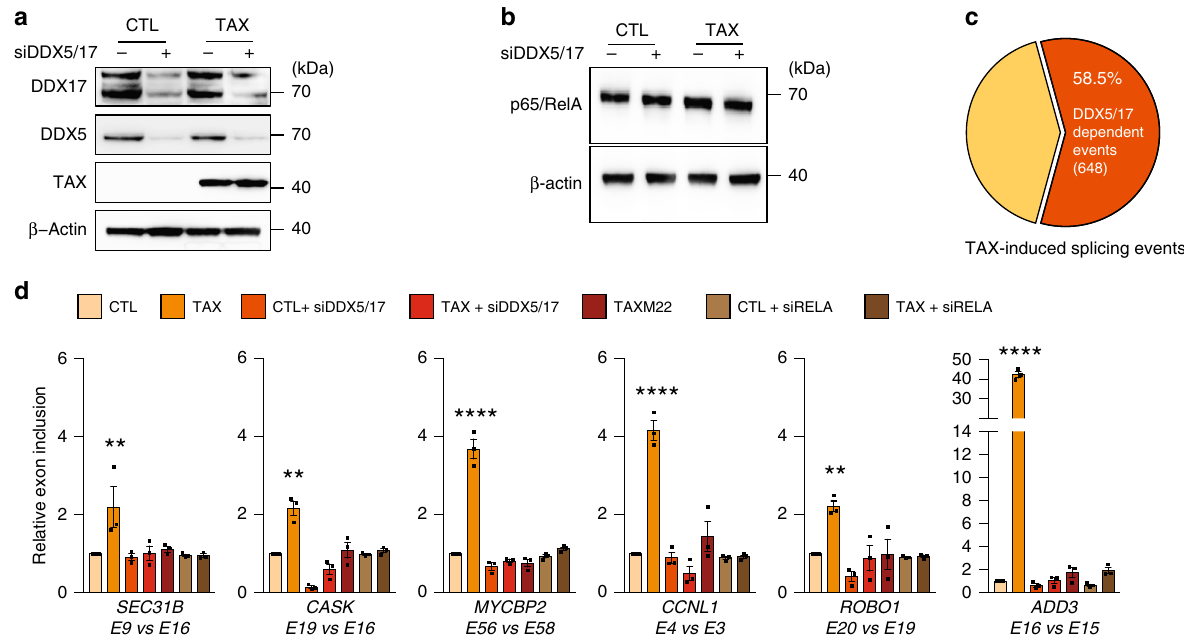
Fig. 3 DDX5/17 regulates Tax splicing targets in an NF-kB-dependent manner. a Western blot analysis of DDX5 and DDX17 expression in HEK cells expressing or not Tax and depleted or not of DDX5 and DDX17 by siRNA. b Western blot analysis of RELA and β -actin upon Tax expression and siRNA- DDX5/17 delivery. c Splicing events modi fi ed upon the depletion of DDX5/17 in Tax-positive HEK cells. The signi fi cant threshold was set to ≥ 2 in comparisons between TaxvsCTL and TaxsiDDX5/17vsCTL. For b and c , a representative image from three independent experiments is shown. d Validation of alternative splicing predictions of a set of Tax- and DDX5/17-regulated exons. TaxM22 and siRNA-mediated RELA depletion were used in order to assess the dependency of splicing events on NF- κ B activation. Histograms represent the results of exon-speci fi c quantitative RT-PCR measurements computed as a relative exon inclusion (alternatively spliced exon vs constitutive exon re fl ecting the total gene expression level). All genes but MYCBP2 were unmodi fi ed at the whole transcript level upon Tax expression (Supplementary Fig. 2c). Data are presented as the mean ± SEM values from biological replicates. Each black square represents a biological replicate. Statistical signi fi cance was determined with two-way ANOVA followed by Fisher ’ s LSD test (** p < 0.01, **** p < 0.0001). Exact p -values for Tax vs CTL: 0.0068 for SEC31B; 0.0084 for CASK; <0.0001 for MYCBP2; <0.0001 for CCNL1; 0.0063 for ROBO1; <0.0001 for ADD3. Source data are provided as a Source Data fi